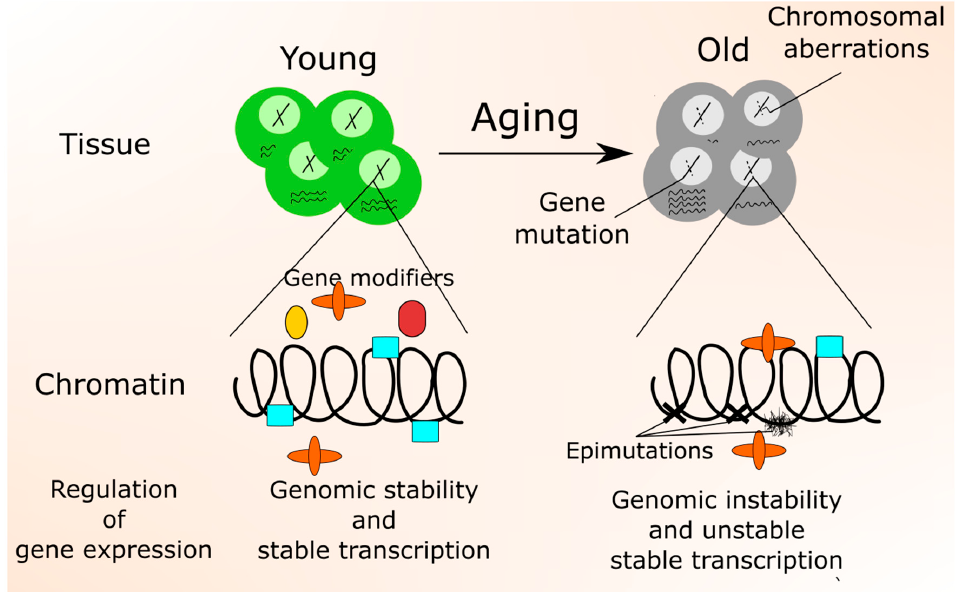
Figure 4. The crosstalk between epigenetic changes, transcription, and genomic instability. In a young organism, transcription is fully controlled and produced the same amount of mRNA in the cells that activate the same genes. In these cells, normal chromatin state and genomic stability are maintained. With increased age, genomic instability increases, resulting in gene mutations and chromosomal aberrations and unstable transcription. Increased DNA damage may result in DNA damage response inducing the recruitment of epigenetic modifiers of chromatin structure and locally resuming its conformation, which may partly stabilize the transcription of neighboring genes. Epimutations, which accumulate in later life, may hamper this process.